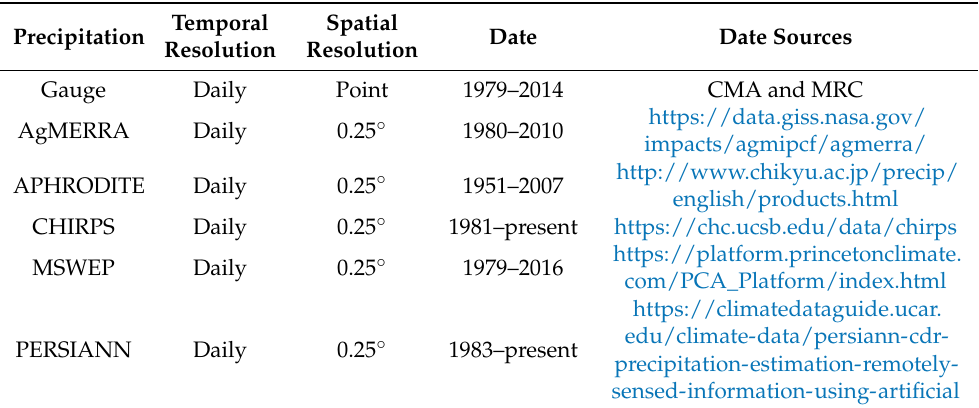
Table 1. Characteristics of the precipitation products used in this study. CMA = China Meteorological Administration; MRC = Mekong River